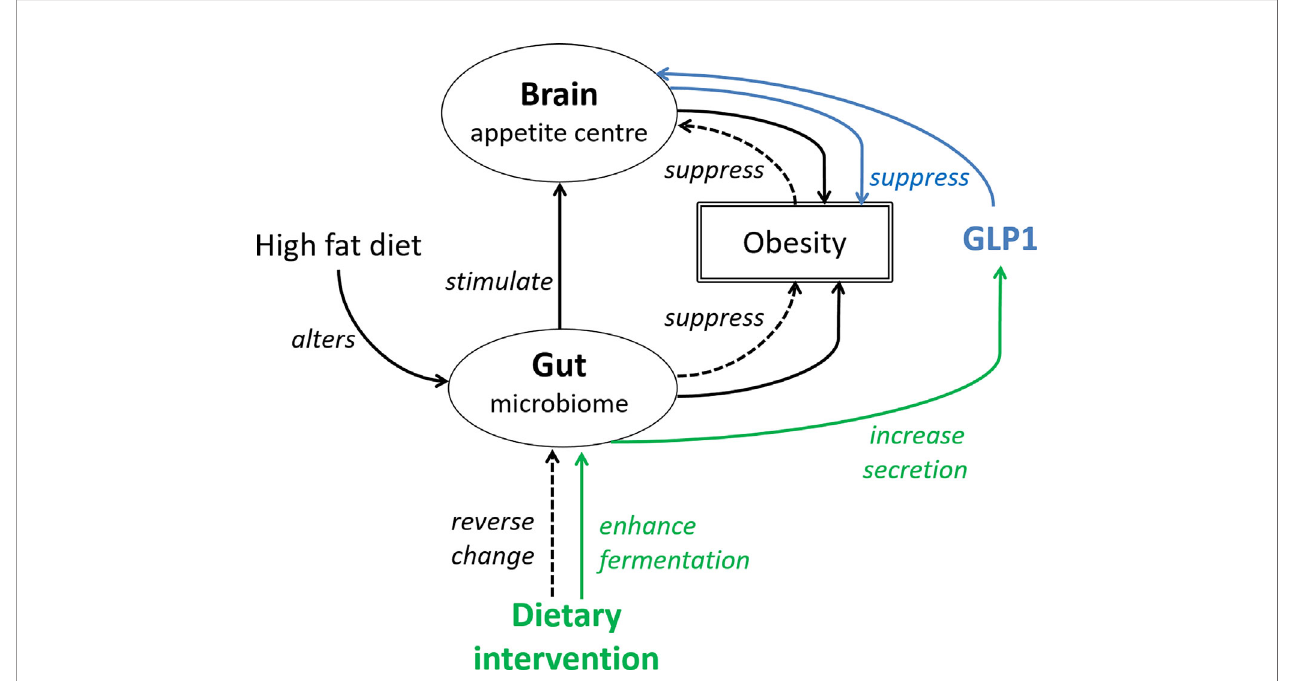
FIGURE 1 | The gut-brain axis is central to the effects of GLP1. Solid black line: High fat diet alters the gut microbiome, which then stimulate the appetite leading to increased food intake and body weight gain. The interaction between HFD and gut microbiome also increases adiposity. Blue line (pharmacological approach): GLP1 or GLP1 receptor agonist suppresses appetite and reverses the increase in body weight. Green line (non-pharmacological approach): dietary fi bers by enhancing fermentation in the large intestine, increase GLP1 secretion. Dotted line (non-pharmacological approach): dietary antioxidants may reverse changes of the gut microbiome induced by high fat diet, subsequently suppressing obesity and food